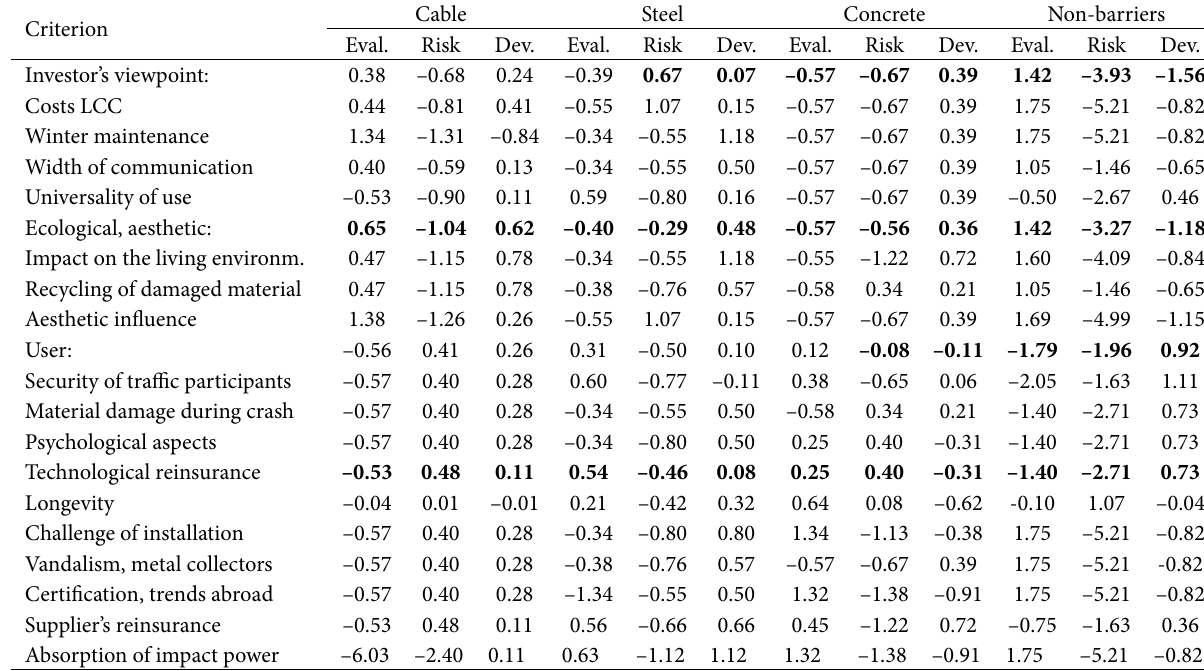
Table 6. Detailed statistic of a variant